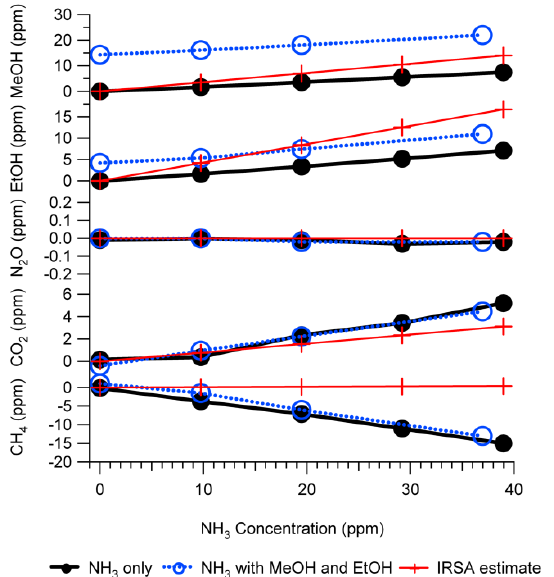
Figure 6. Interference of NH closed circles are experimental responses to NH blue dash lines with open circles are experimental responses to NH MeOH (12.8 ppm) and EtOH (4.5 ppm), and red thin-lines with crosses are estimation by the IRSA method for the NH not humidified.